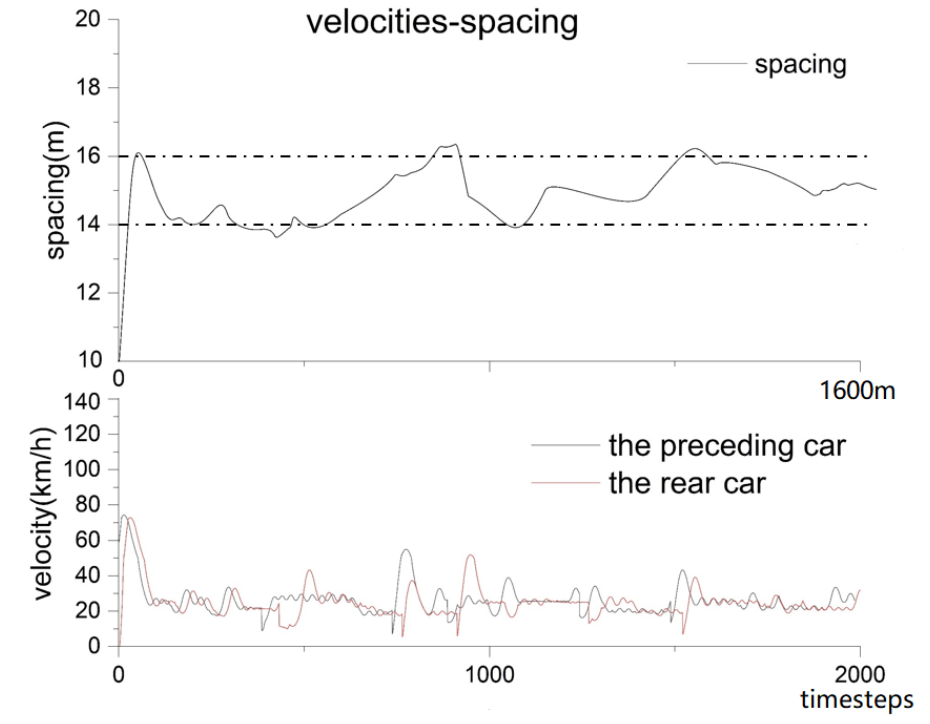
Figure 6. The dotted line indicates the spacing range in the ideal state. Initial vehicle spacing is 10 m. The distance traveled using the Subsection-PPO algorithm while maintaining a safe spacing accounted for 93.8% of the total